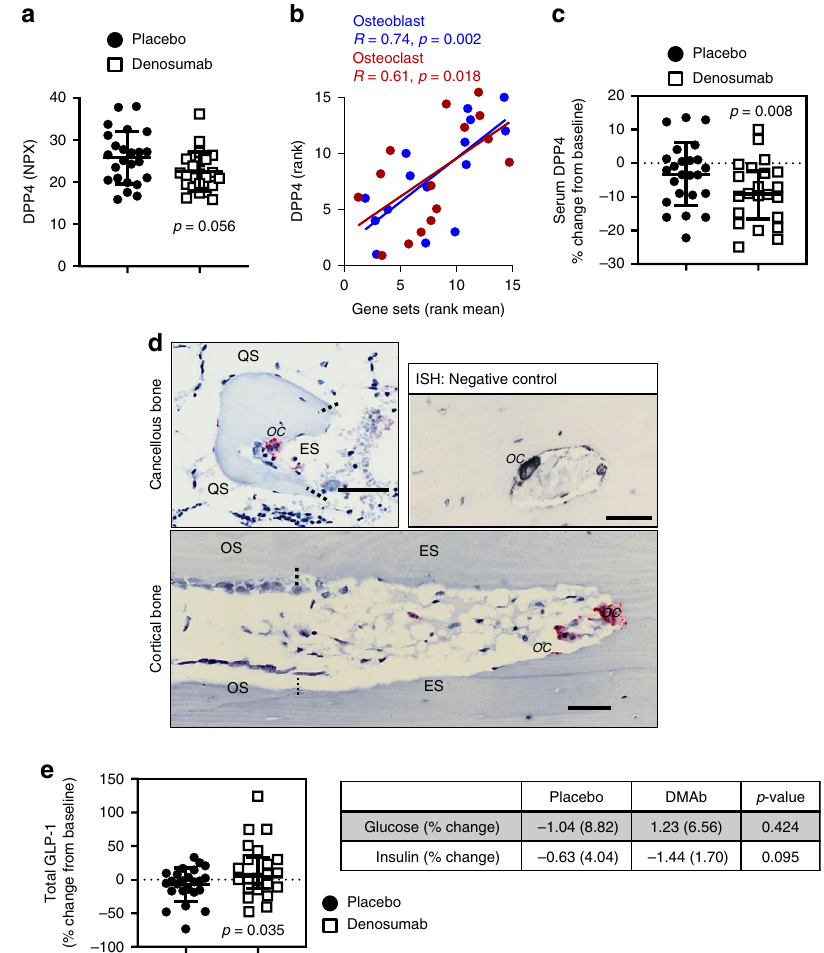
Fig. 4 Bone marrow plasma DPP4 protein linked to bone remodeling. a Bone marrow plasma DPP4 levels in the placebo- vs. DMAb-treated participants as measured by Olink Proteomics ( N = 24 participant samples/group). Bone marrow DPP4 is measured in NPX (normalized protein eXpression),